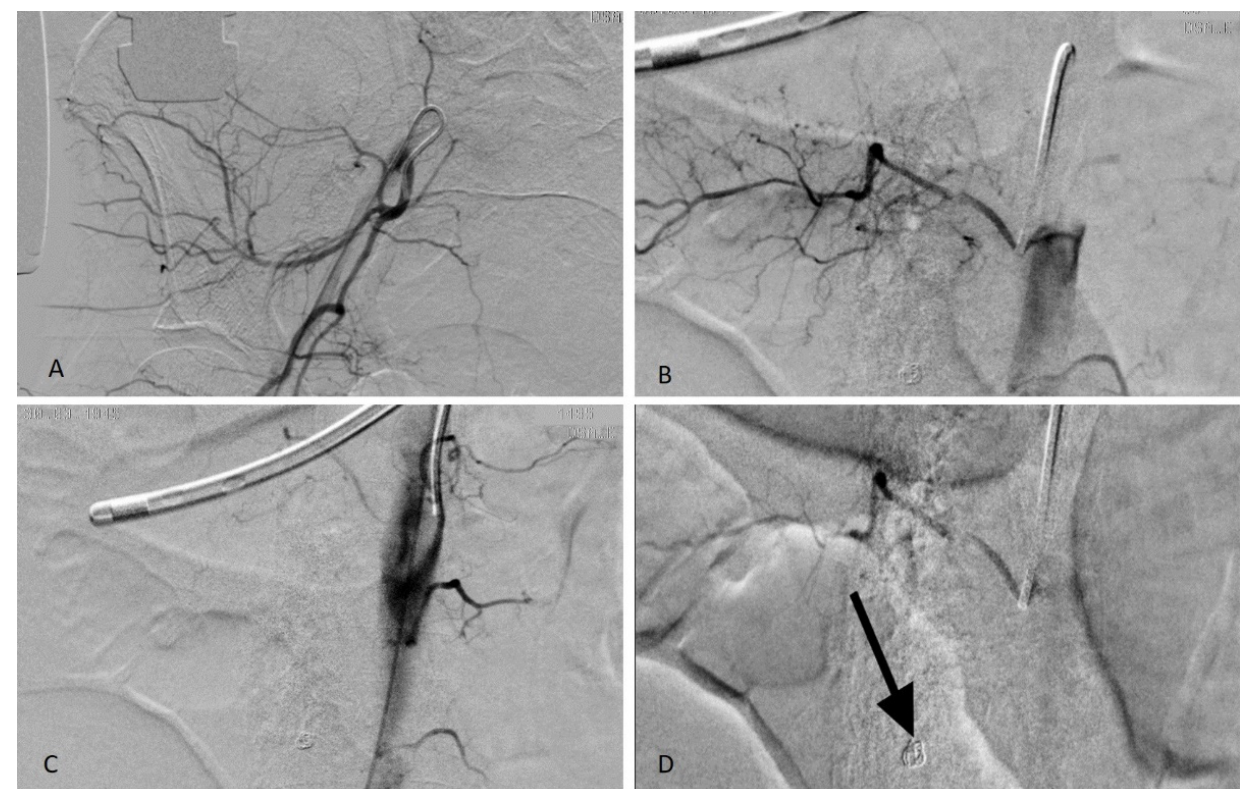
Figure 4. ( A ) Catheterism of the right hypogastric artery to reach the right ileo-lumbar artery (anastomotic territory); ( B ) Lumbar artery catheterization showing tiny bleeding spots; ( C ) Post-embolization angiogram: right lumbar arteries occluded; ( D ) Stop flow post embolization with particles (PVA contour 350–500) in the 4th lumbar artery and coil in the 5th lumbar artery